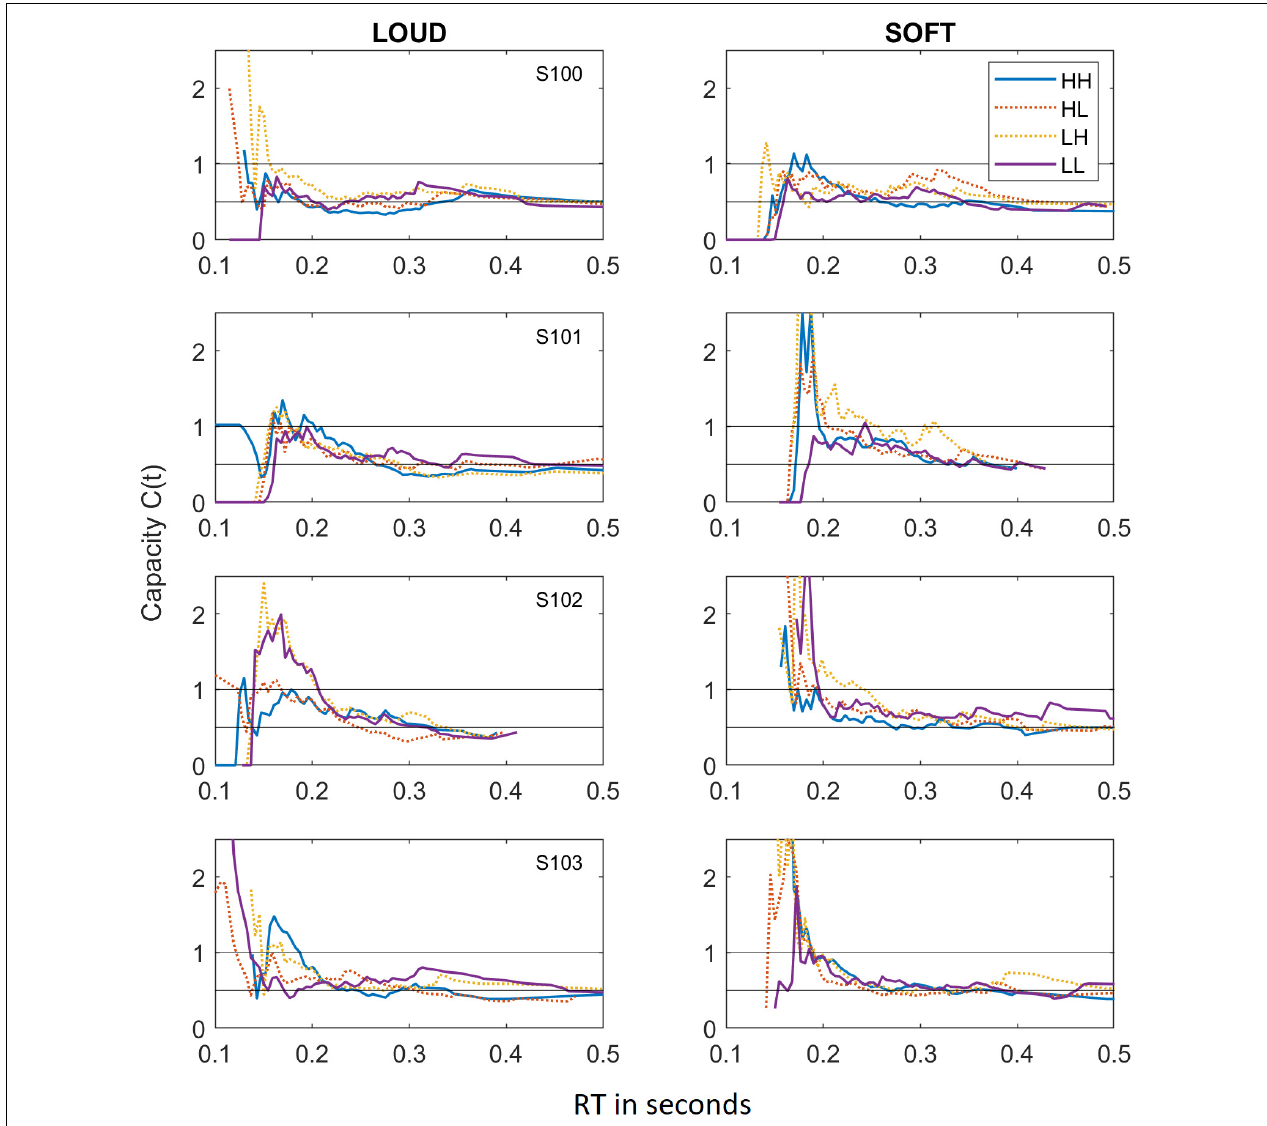
FIGURE 3 | Capacity functions obtained for the LOUD scenario (left panels) and the SOFT scenario (right panels) . As in Figure 2 , data from the different dual-target conditions (HH, HL, LH, and LL) are depicted by lines of different colors and solid lines indicate HH and LL whereas dotted lines reference HL and